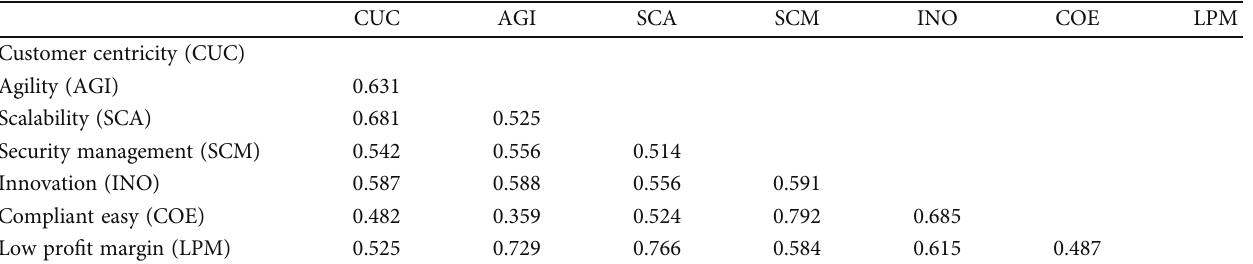
Table 5: HTMT ratio.